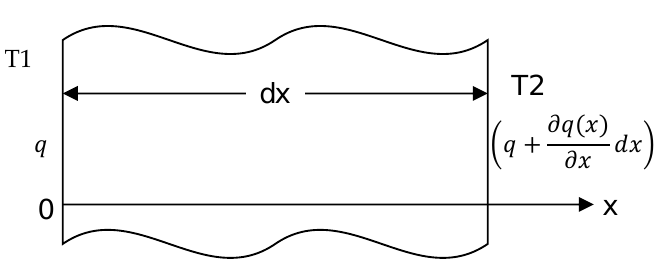
Figure 1. Heat flow by conduction.